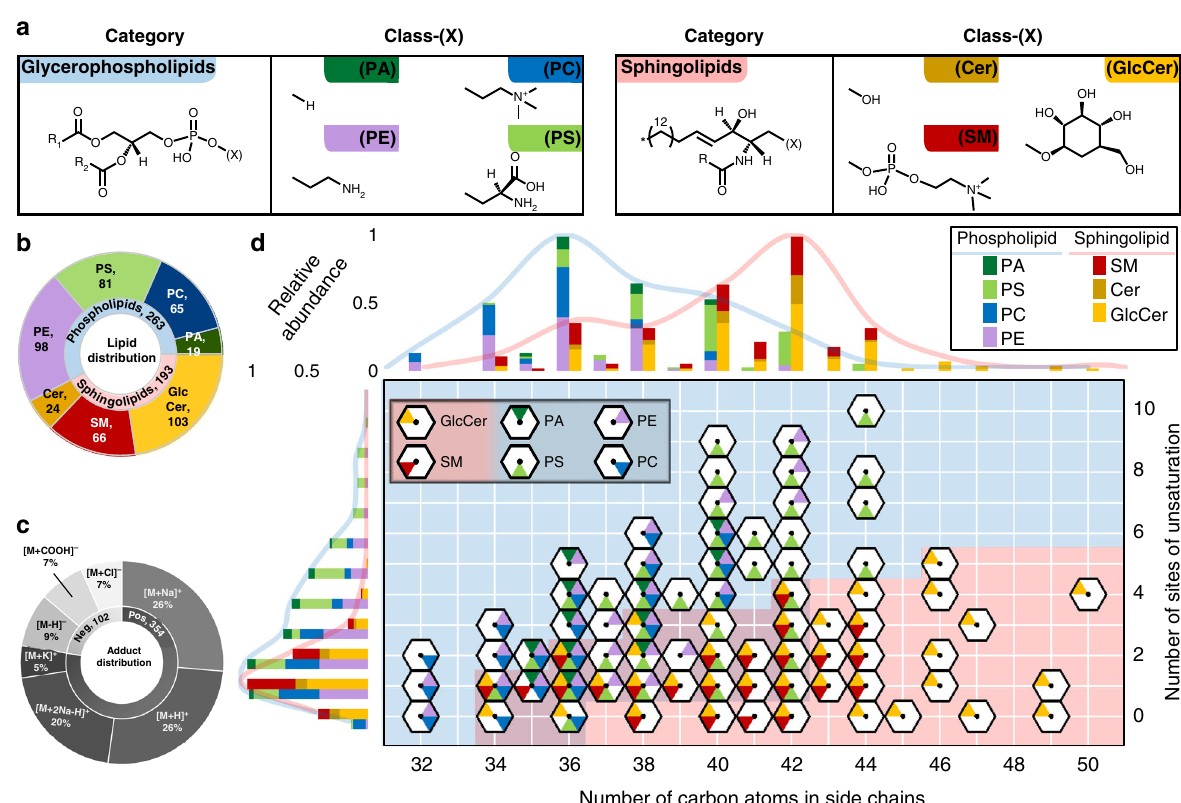
Fig. 1 Lipid population observations. a Investigated lipids are classi fi ed by head group. Expected and observed species are listed by the total number of carbons or double bonds in the fatty acid tails. b The distribution of observed lipids. The inner ring denotes lipid categories whereas the outer ring details features observed in each lipid class. c The distribution of adducts observed resulting in the species of quasi-molecular ion detected. d Central graph represents population of lipid summed chain lengths ( x -axis) and degrees of unsaturation ( y -axis) identi fi ed, separated by class and excluding adduct and modi fi cation information. The Cer class of lipids are included with GlcCer. Each colored wedge of the hexagons represents an identi fi ed lipid as indicated in the key. Background shading delineates lipid categories, with sphingolipids in red and glycerophospholipids in blue. Left histogram displays distribution of degree of unsaturation, normalized to each category. Top histogram shows summed chain length distribution, normalized to each